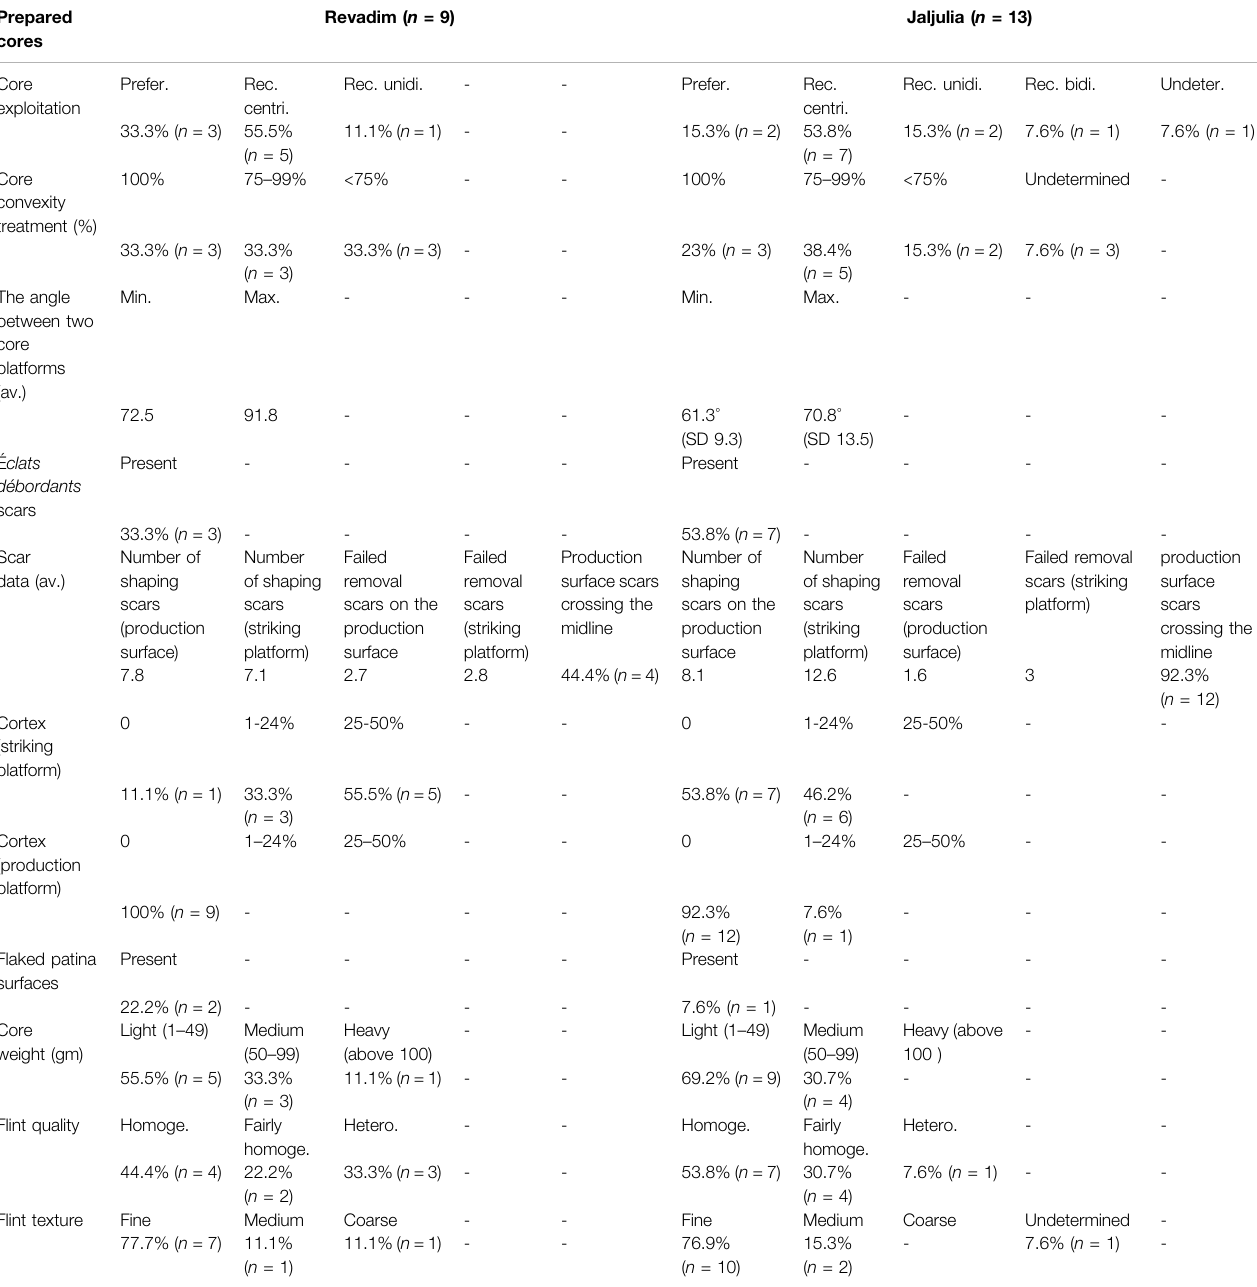
TABLE 3 | Major attributes of prepared cores (general) from both sites. Prefer. (Preferential); Rec. (Recurrent); centri. (centripetal); uni. (unidirectional); bidi. (bidirectional); Homoge. (Homogeneous); Hetero. (Heterogeneous) Undeter.